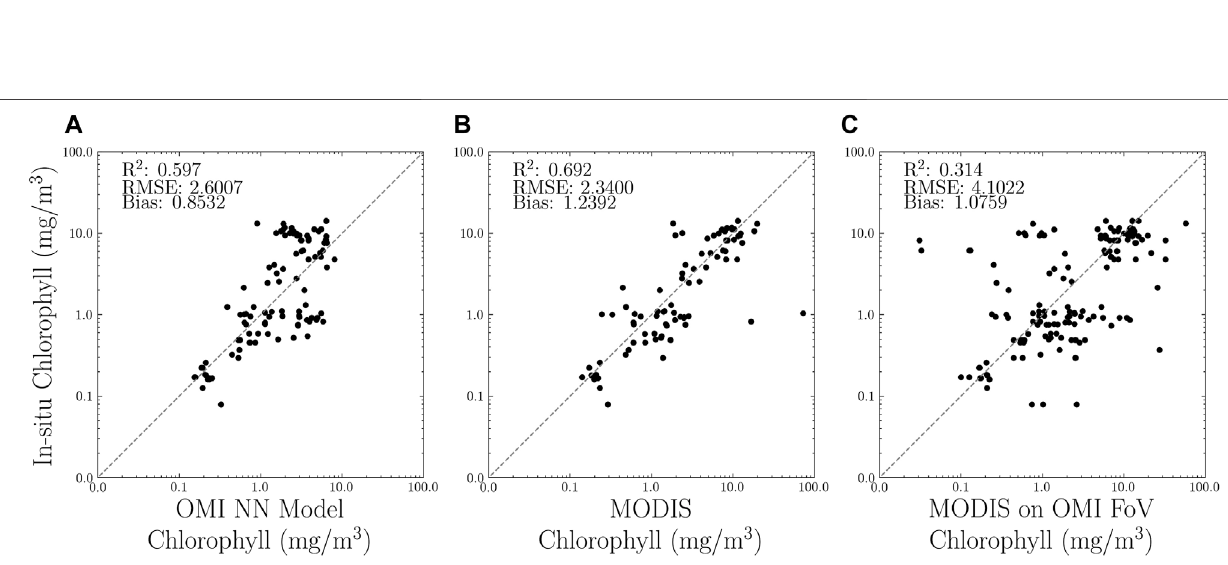
Frontiers in Remote Sensing |